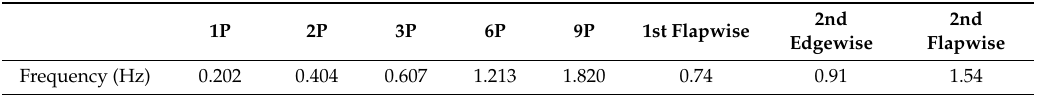
Table 7. Rotational frequencies at rated speed (12.1 rpm) and natural frequencies of the NPU 5 MW blade at 0 rpm.